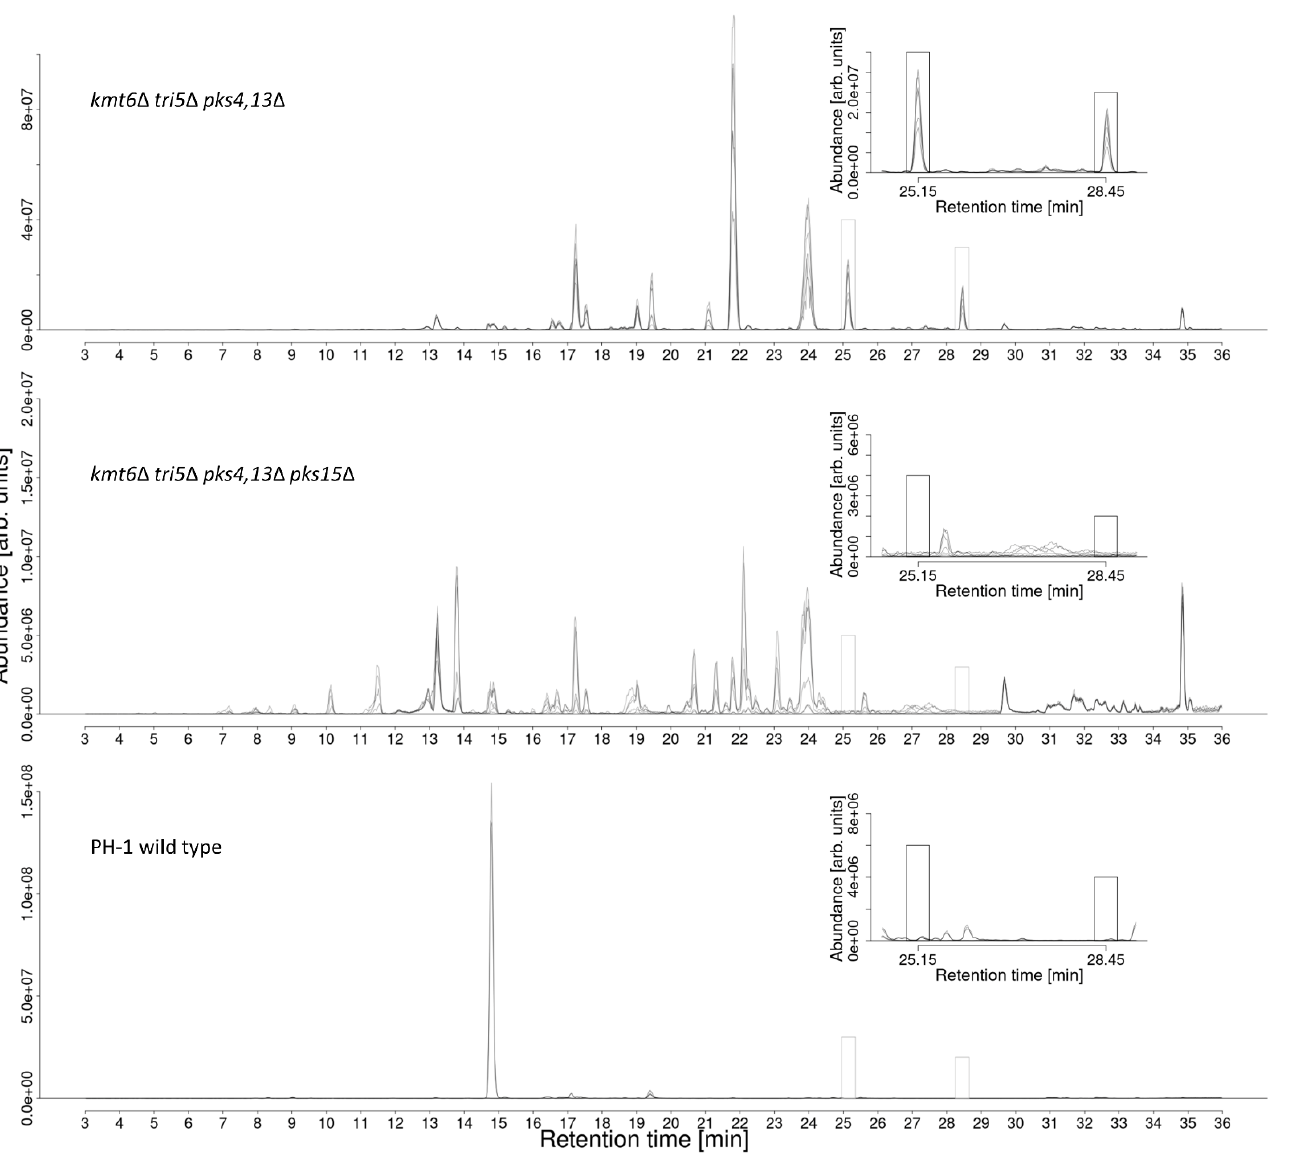
Figure 2. Comparison of basepeak chromatograms with m/z range 500 – 550 of de-repressed kmt6Δ strains #1290 and #1291 (top chromatogram) kmt6Δ pks15Δ knockout strains #2263 and #2266 (middle chromatogram) and PH-1 wild-type (bottom chromatogram) culture supernatant samples. Two additional peaks marked with boxes were found at retention time 25.1 min and 28.4 min, respectively. These were exclusively present in the chromatograms of the strains #1290 and #1291 but missing in those of the pks15 Δ and wild-type strains (on minimal media).